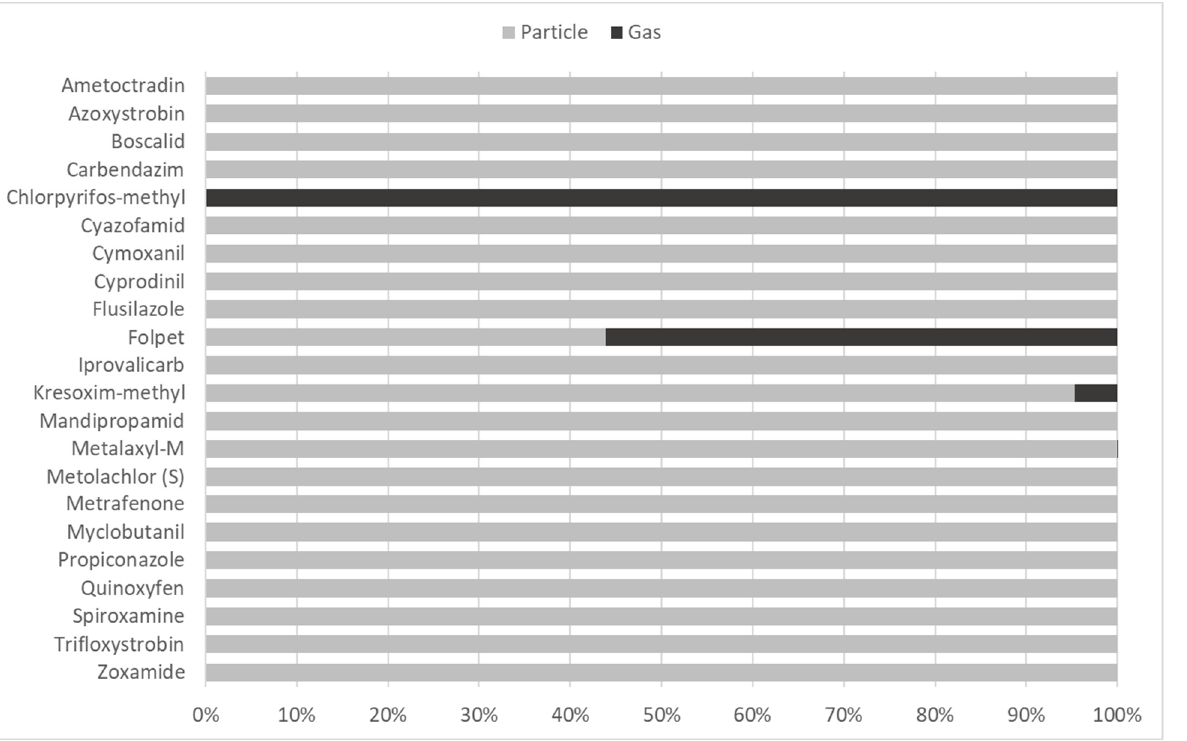
Figure 1. Mean gas and PM10 particle distribution (%) of the 22 pesticides quantified using a DA80 HV-AAS on five consecutive days in June 2013 (Gironde, France). HV-AAS on five consecutive days in June 2013 (Gironde,